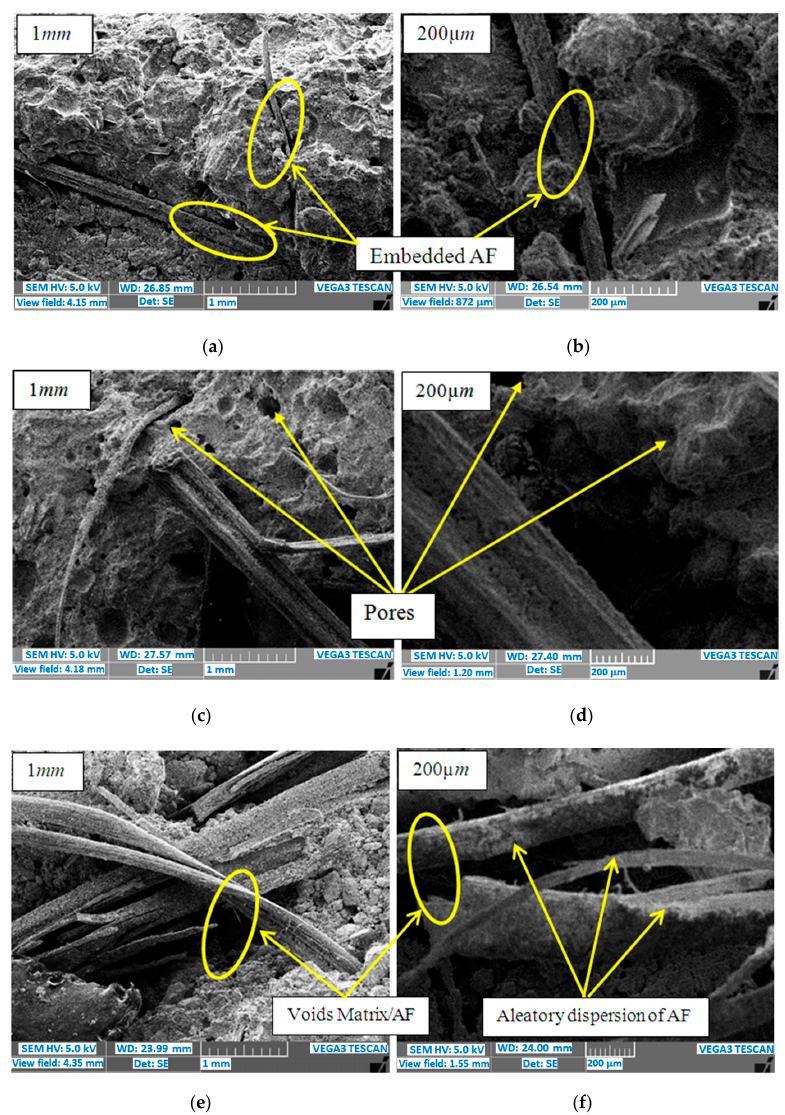
Figure 5. Scanning electron microscope (SEM) pictures of composites at two di ff erent scale lengths 1 mm and 200 µ m: ( a , b ) AFRM 1%, ( c , d ) AFRM 2%, ( e , f ) AFRM